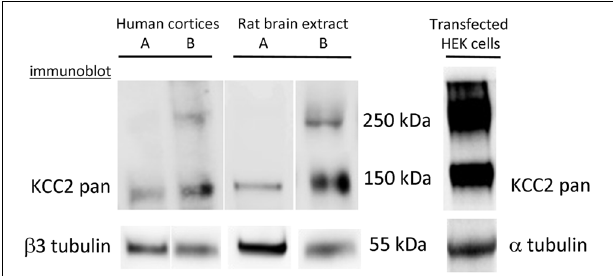
FIGURE 2 | Complexity of interpretation of KCC2 oligomerization. Formation of KCC2 dimer-like complexes depends on the protein extraction procedure and is different for endogenous and over-expressed KCC2. KCC2 extraction using a rapid procedure ( < 1min) either from human cortices or rat brains generates a single band of ∼ 140kDa. The extracts prepared from similar brain samples using the same solutions but with a longer overall time of extraction ( > 4min) always give at least two bands corresponding to monomer (140kDa) and dimer (280–300kDa) of KCC2. The extraction of eGFP-KCC2 over-expressed in HEK-293 cells resulted in the appearance of two bands independently on the procedure of extraction. Similar two-band expression profile of KCC2 was obtained after over-expression of different KCC2 forms (with or without additional tags) into different cell lines (PC-12 and